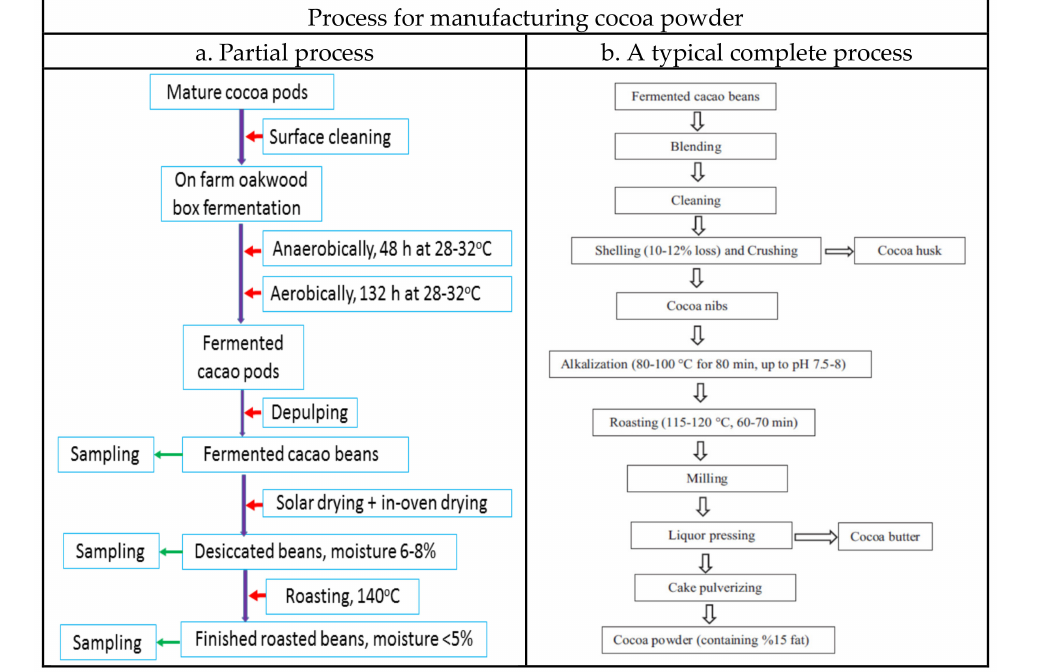
Figure 2. Flowchart for processing cocoa pods and cocoa beans. ( a ) Partial process for study in this 16 of 23 experiment. ( b ) An example of the typical complete process [1]. Reprinted with permission from Ref. [1]. Cacao pods from different cultivars grown in Taiwan Red Yellow